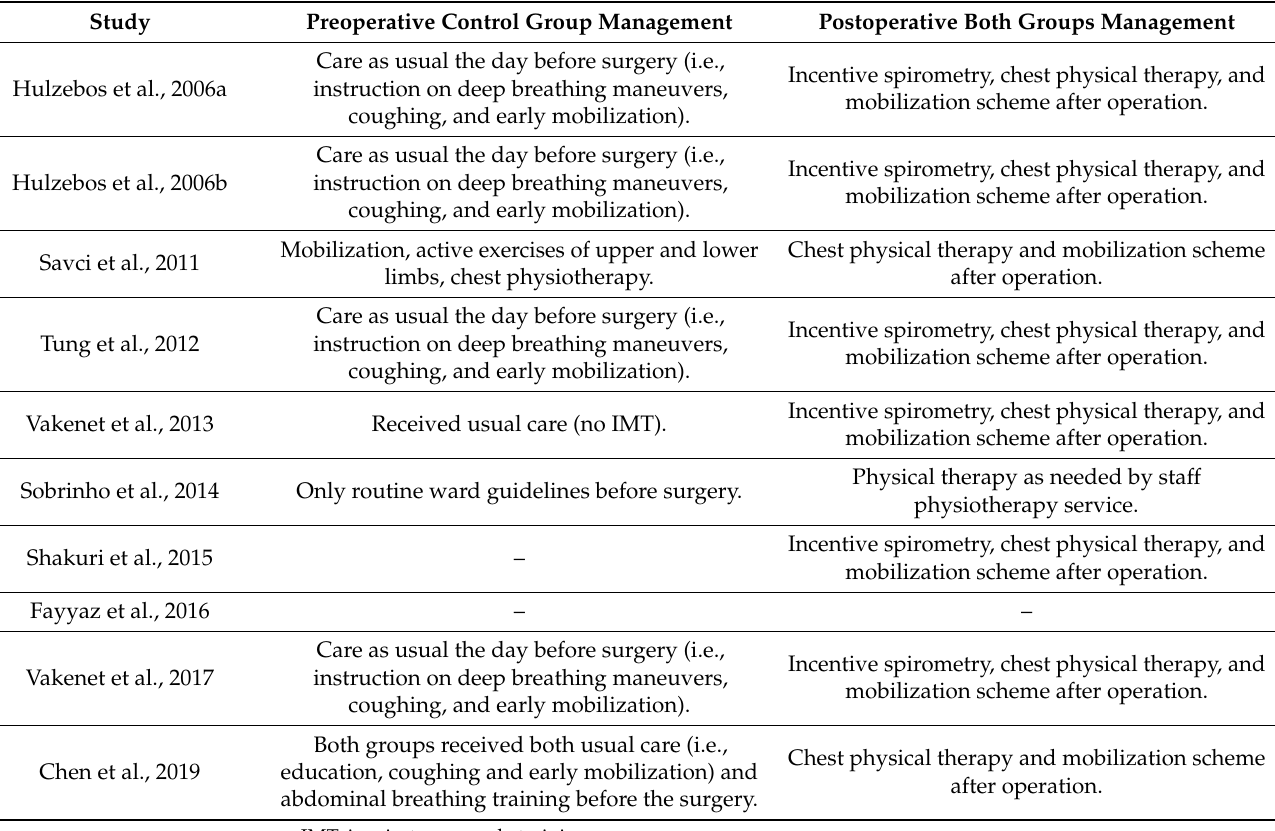
Table 5. Description of the preoperative protocols.